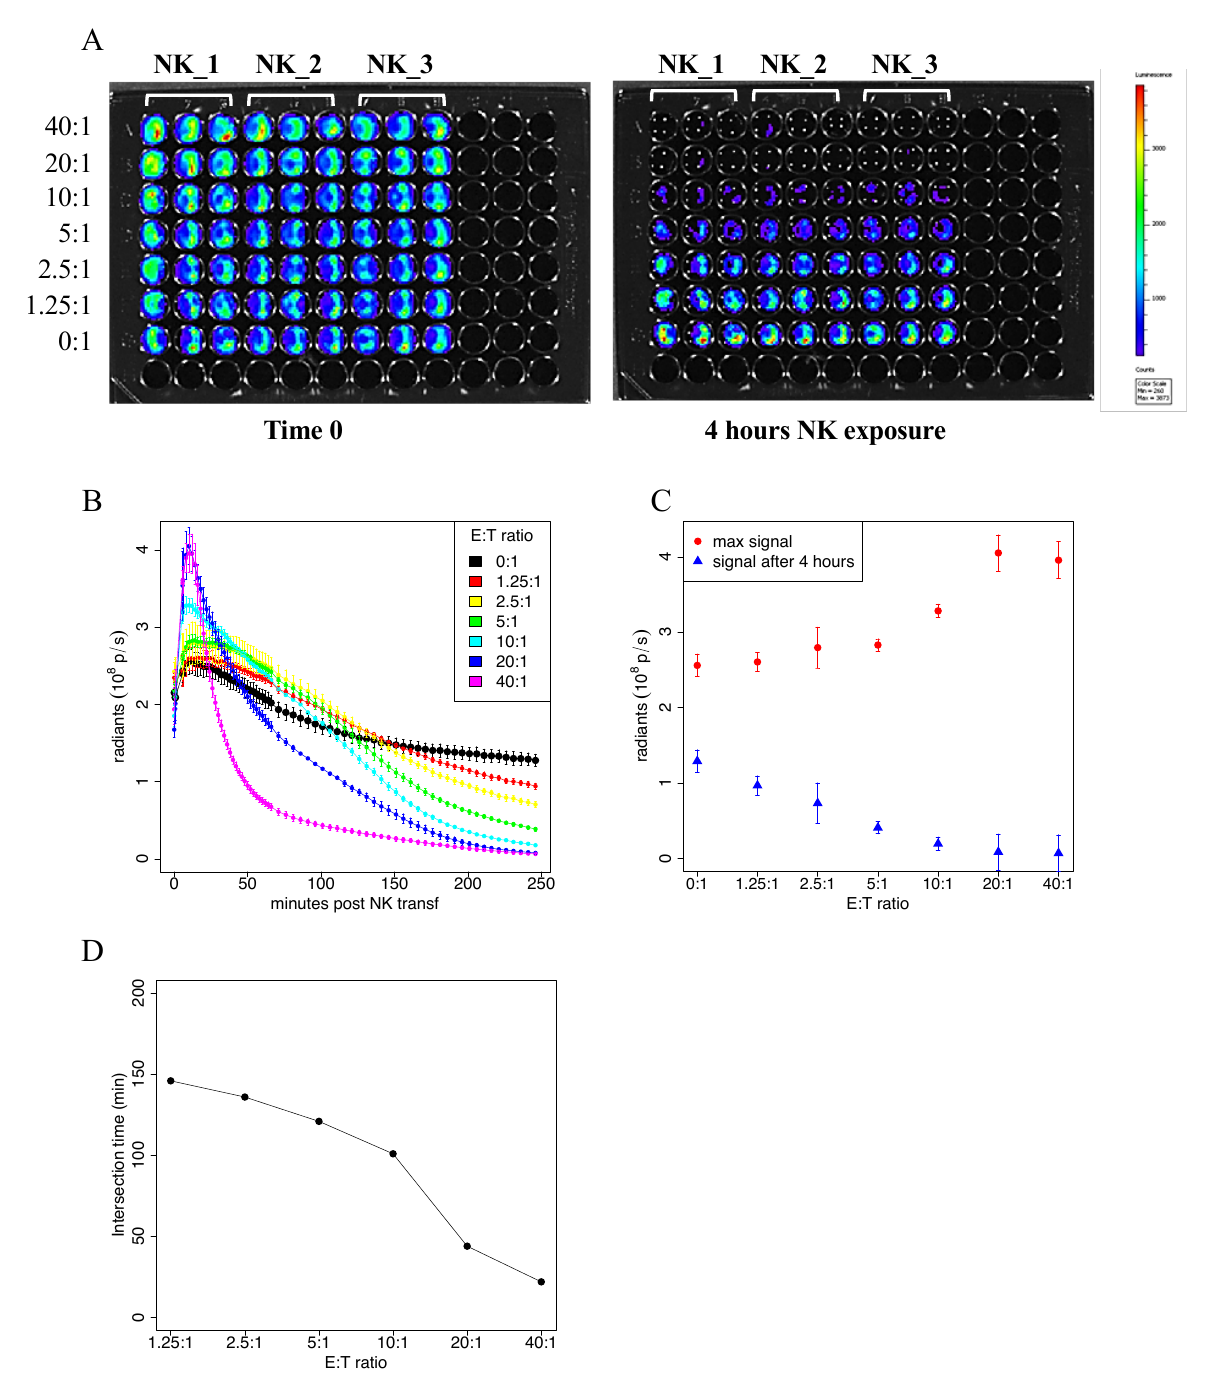
Figure 3. BLI-based cytotoxicity assay. In vitro quantitation of the bioluminescence signal in human hepatocellular carcinoma cells expressing luciferase, HepG2-Red-FLuc. ( A ) Pseudocolor representation at time 0 and after 4 h of the bioluminescence intensity of HepG2-Red-FLuc plated at 5 × 10 4 /well in a cytotoxicity assay where human NK cells from three different patients (NK_1, NK_2, and NK_3), activated with IL2/IL15, were added at decreasing ratios ranging from 40:1 to 1.25:1. ( B ) the thorough kinetic of cytotoxicity was addressed by measuring photon emission every two minutes for the first hour and subsequently every 5 min up to 4 h of total incubation. Average signal values and standard errors were plotted against time post NK cell incubation. ( C ) Peak signal and signal 4 h after NK injection plotted against NK concentration. ( D ) Intersection time, i.e., the time at which the time–intensity curve intersects the control time–intensity curve, plotted against NK concentration. ( A – D ) Data shown are representative of three experiments performed in similar conditions using NK cells isolated from three different